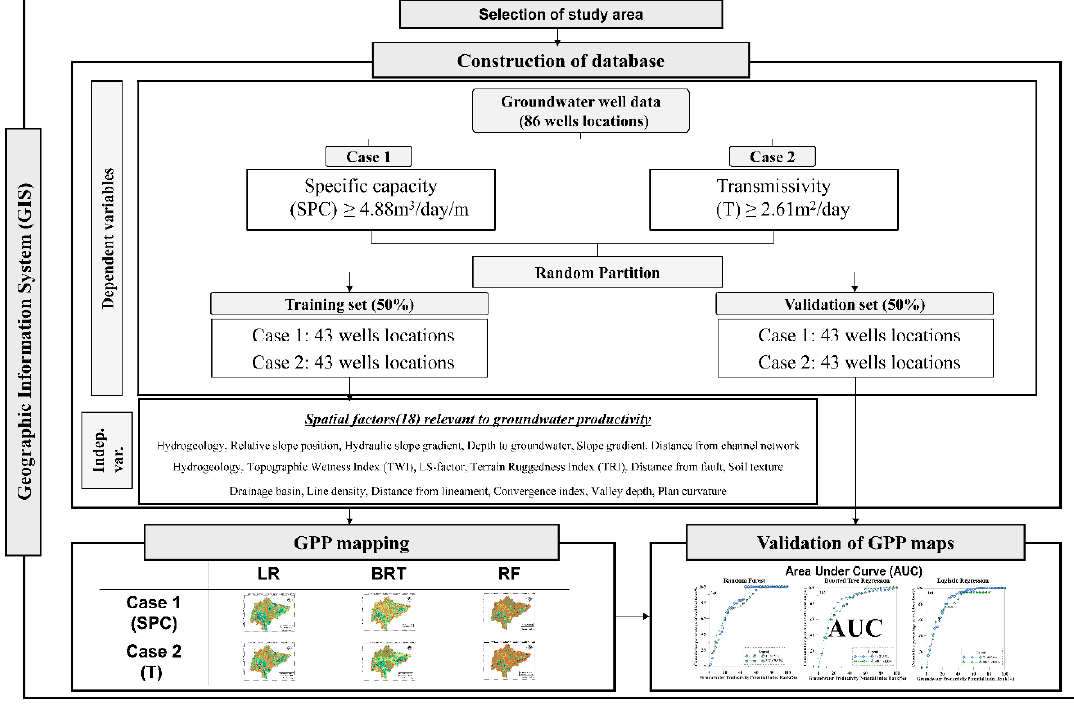
Figure 3. Flow chart of the study procedures.